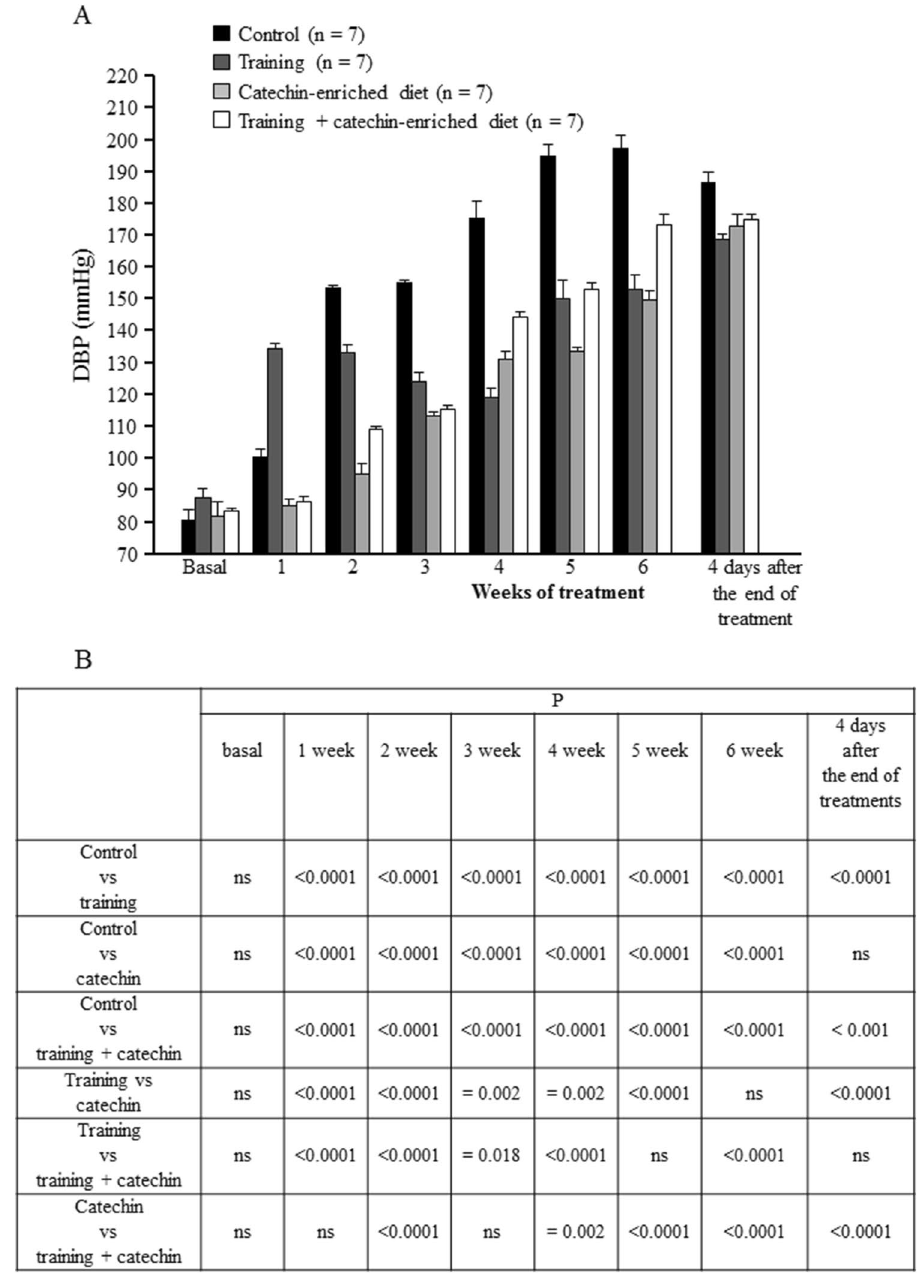
Figure 5. Time-course of diastolic blood pressure (DBP, mean ± SEM) in the different groups of rats considered ( A ). Summary of the statistical analysis results ( B ).